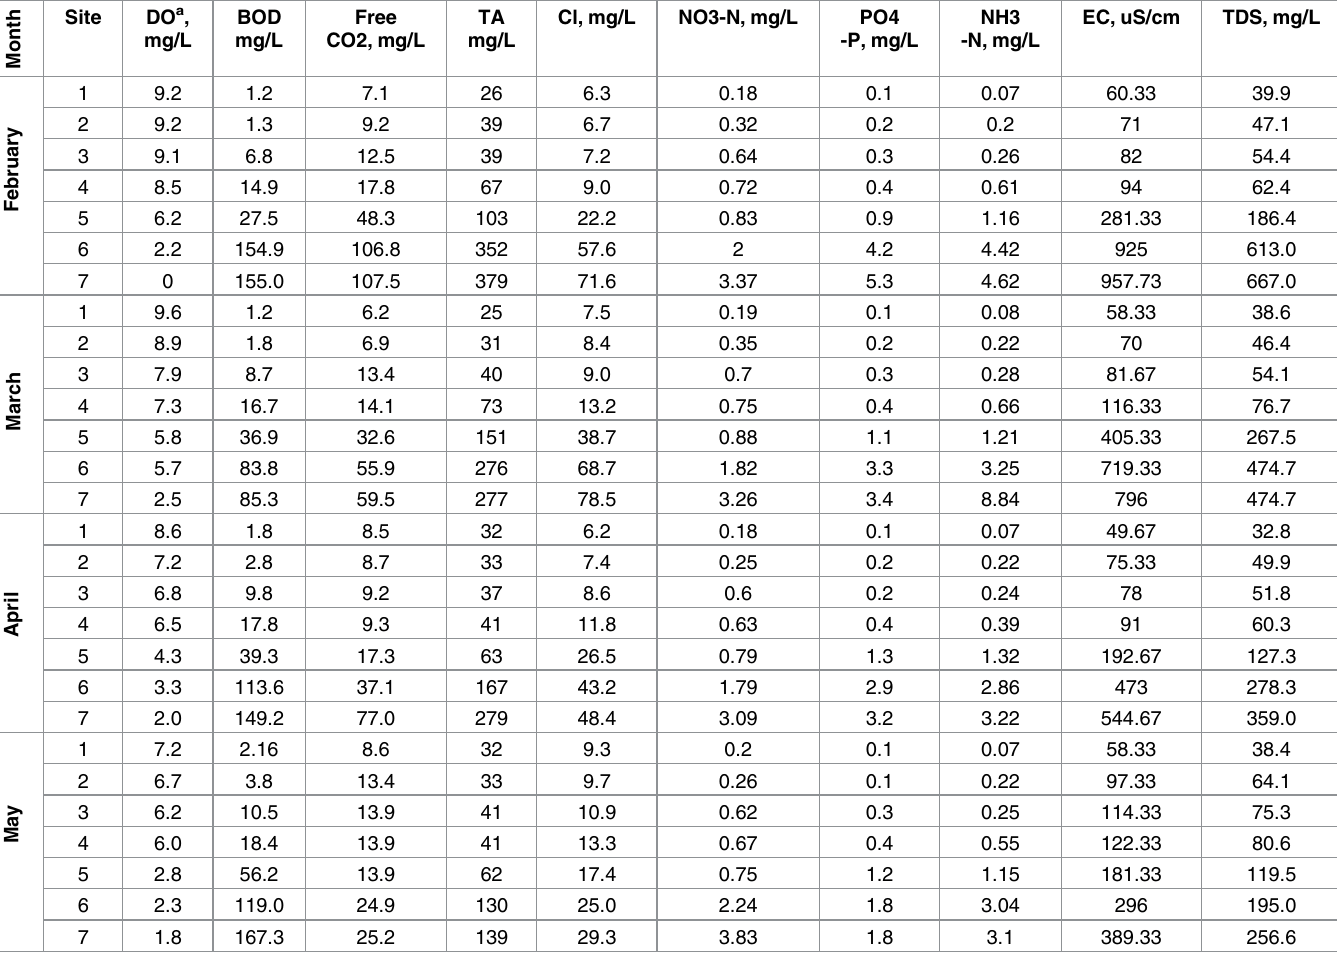
The water quality of the river during the low flow months in 2006 is given in Table 5. Water qualities are good in upstream and bad in downstream regions and varied gradually from Site 1 to 7. Each monitor records the amount of each chemical element in river when the water Table 5. Water quality of Manahara river in different sites. h Site DO a on t M